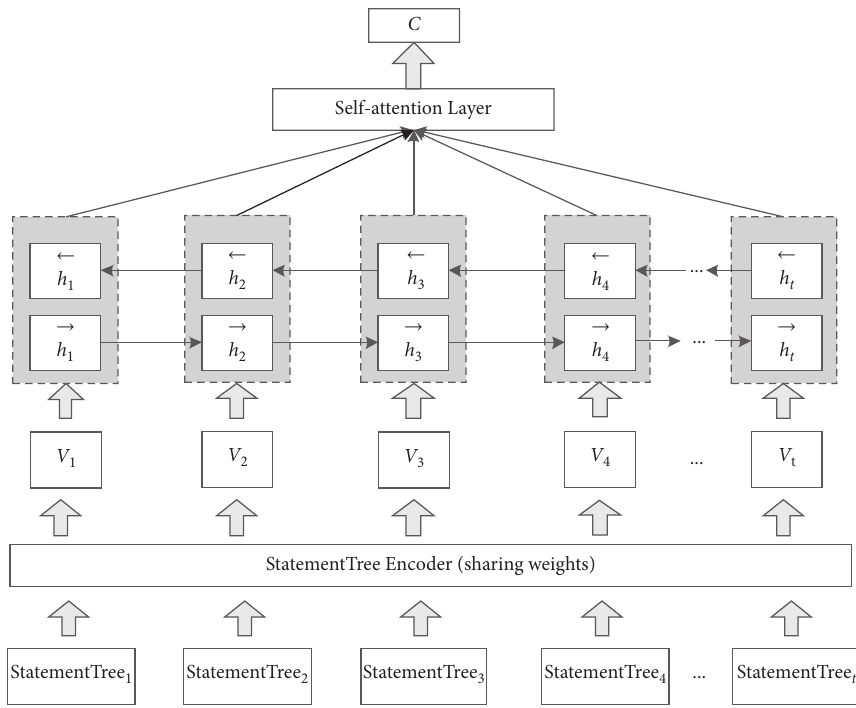
Figure 5: Representation model with